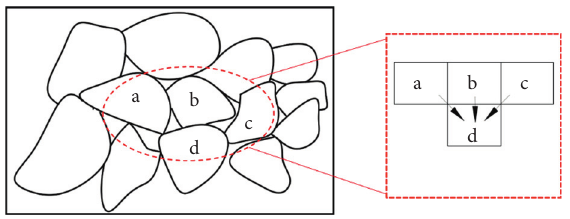
Figure 1: Movement of the broken